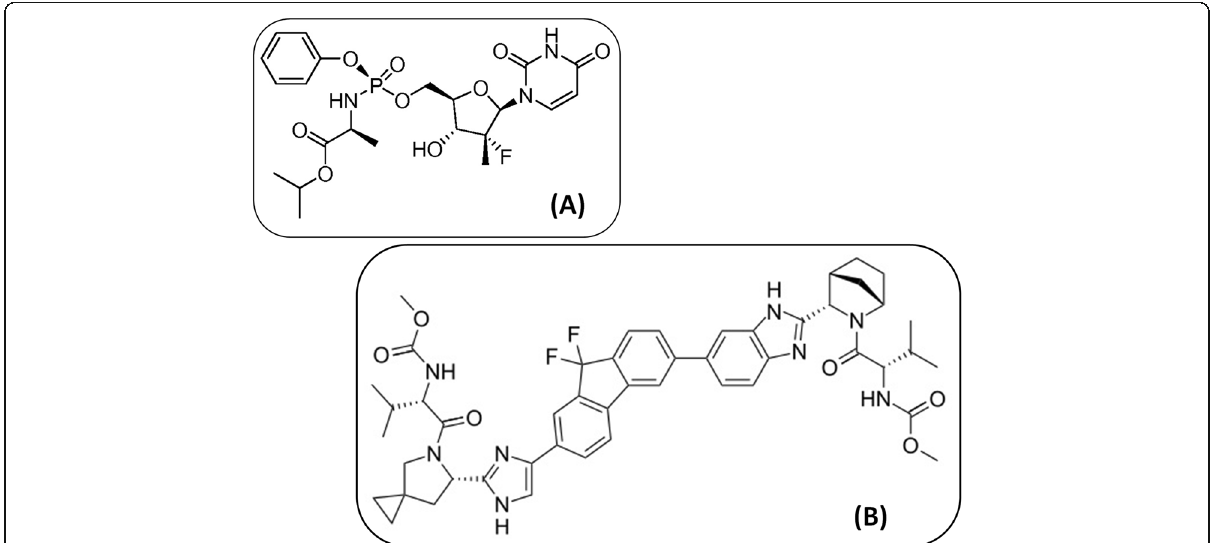
Fig. 1 Chemical structure of SBR (a) and LPV